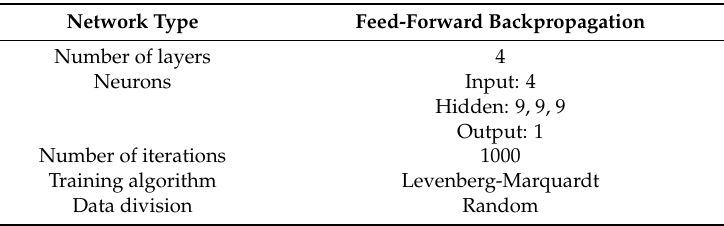
Table 2. The properties of the proposed neural network.